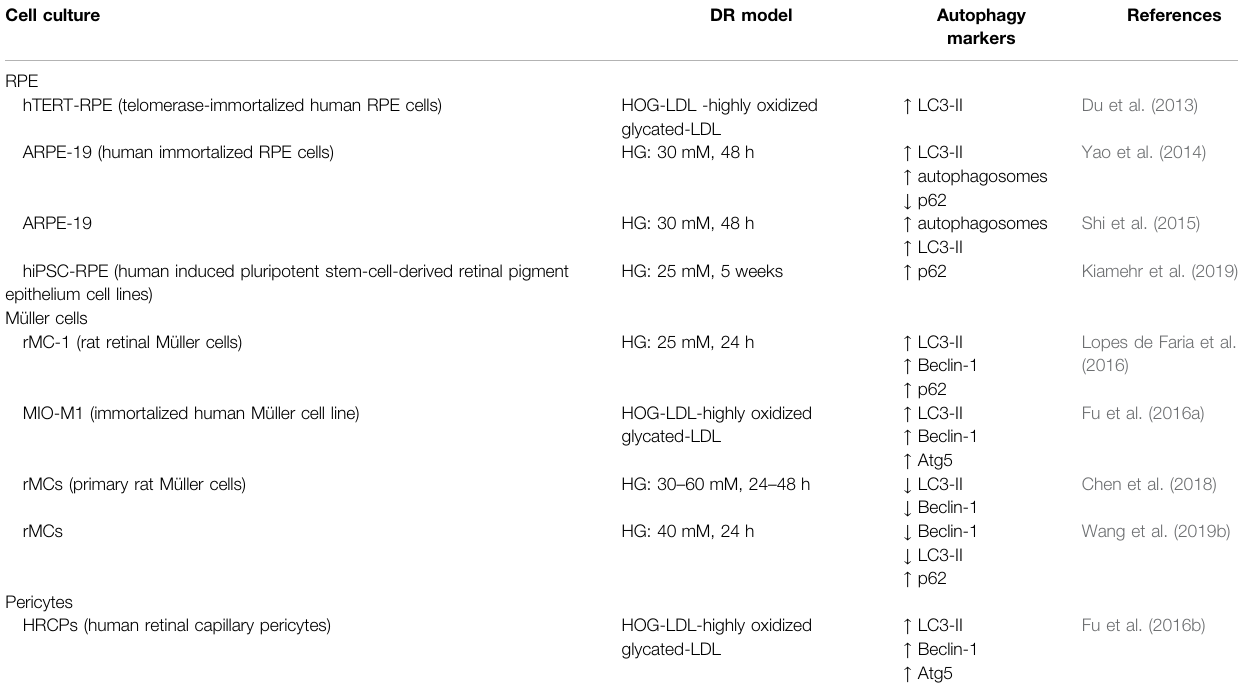
TABLE 2 | Autophagy modulation in cell culture models of diabetic retinopathy. Cell